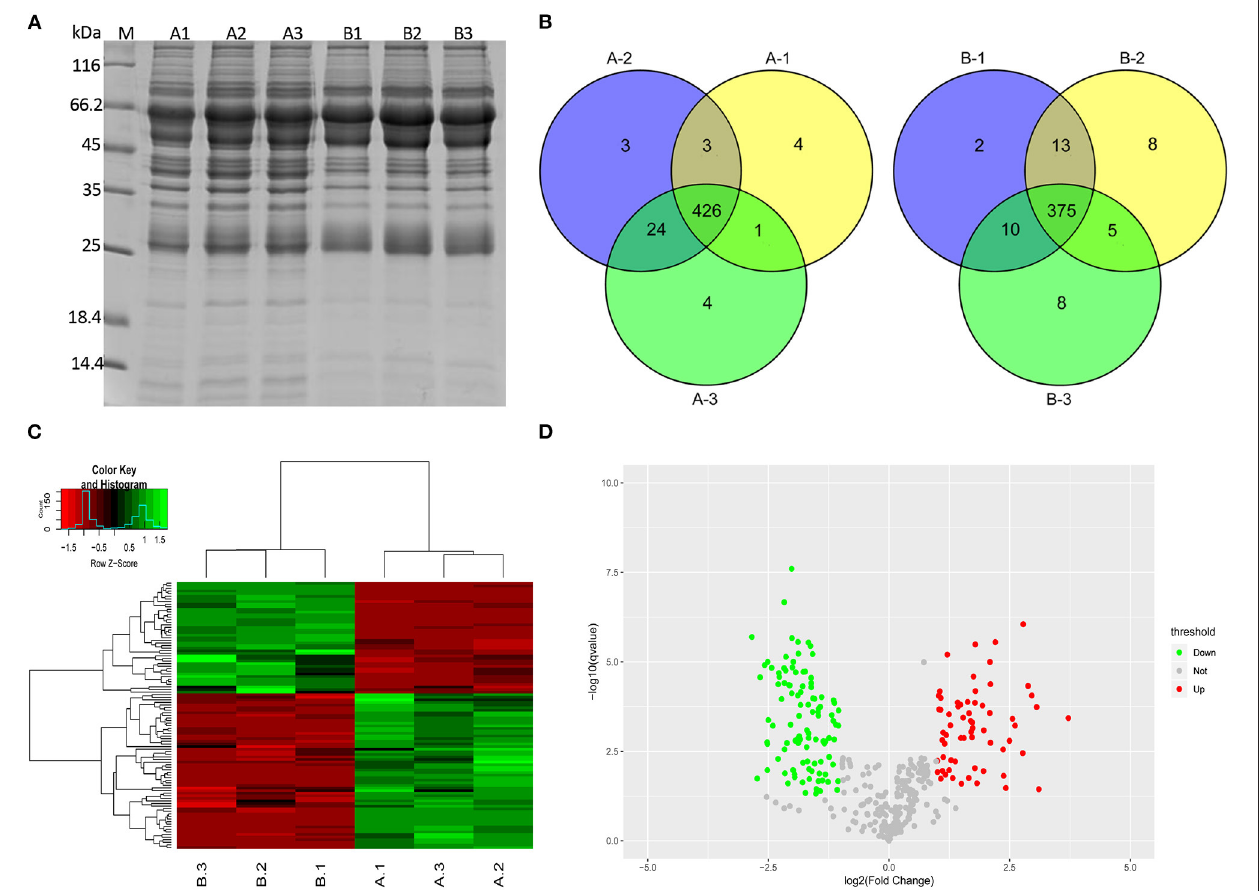
FIGURE 2 | Secreted proteins were identified for Mycoplasma bovis P1 (virulent) and P150 (attenuated) strain by label-free quantitative proteomics analysis. (A) The extracted secretomes were checked with SDS-PAGE. Lanes A1, A2, and A3 and B1, B2, and B3 represent triplicate samples from M. bovis P1 (A1-3) and P150 (B1-3), respectively. M represents the reference protein with the molecular weight labeled on the left. (B) Venn diagrams of the secreted proteins from the P1 and P150 strain in triplicate. (C) Hierarchical cluster analysis was conducted for the differentially expressed proteins. (D) Distribution of differentially regulated proteins in the P1 and P150 strain. Scatter plots of log2-fold change on the x-axis against the -log P -value on the y-axis for significantly quantified proteins. Increased expression is labeled in red, while decreased expression is labeled in green.